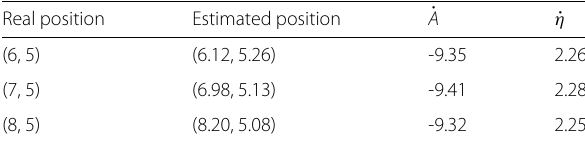
Table 4 Localization results and tracked